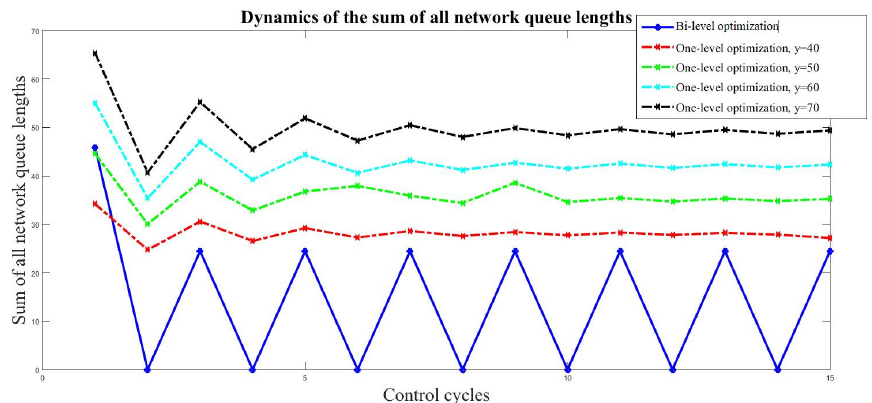
Figure 12. Values of the total number of waiting cars in the network per cycle.